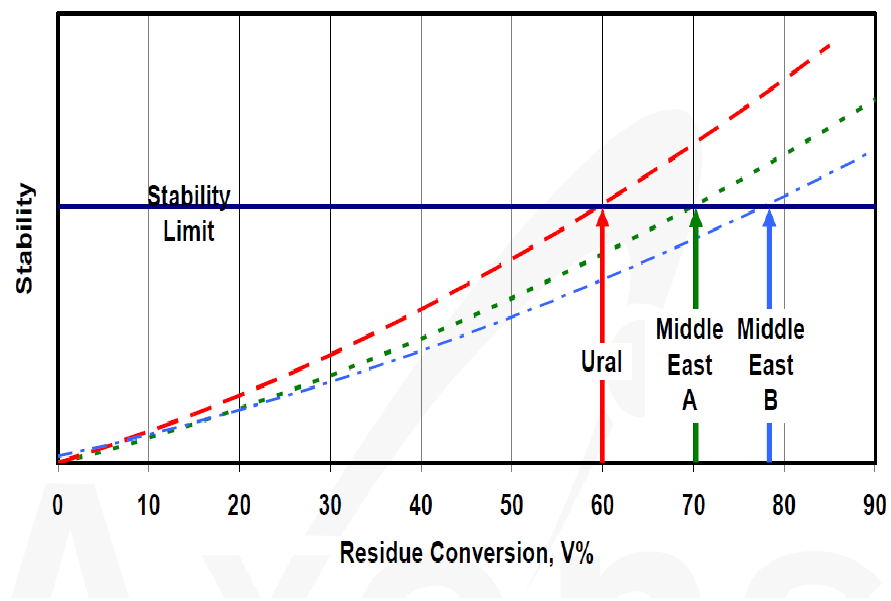
Figure 1. The effect of crude oil type on the conversion level in ebullated bed vacuum residue hydrocracking at the same product stability (product sediment content). (Adapted with permission from Ref. [21] Copyright 2014, copyright Elsevier) (This data is taken from the licensor of the commercial ebullated bed vacuum residue hydrocracker under study.).